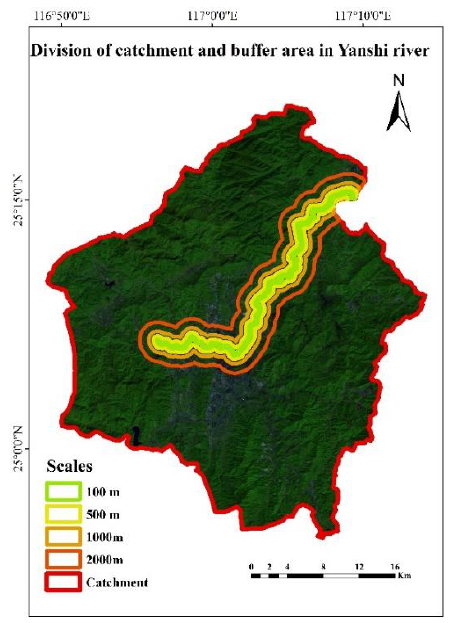
Figure 2. The division of buffer zones in Yanshi River. Table 2. Introduction of landscape